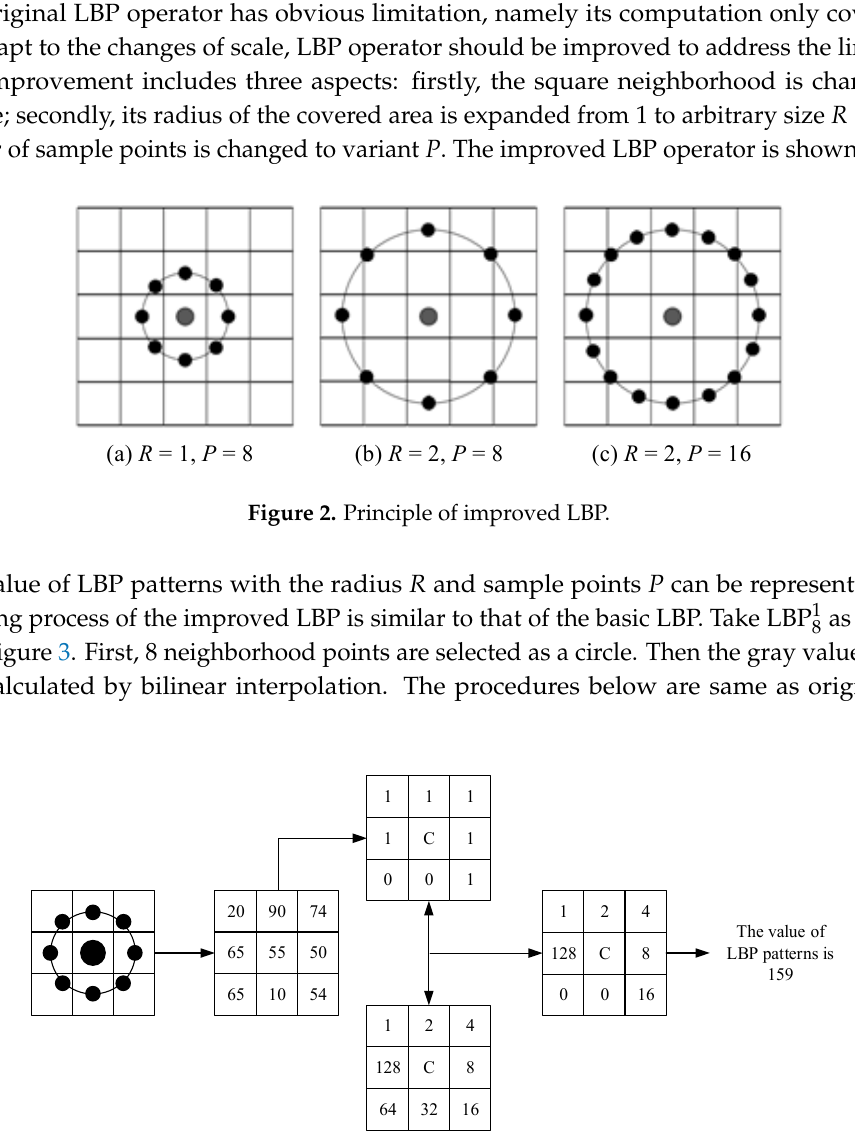
Figure 3. Encoding process of the improved LBP (cid:2876)(cid:2869) .